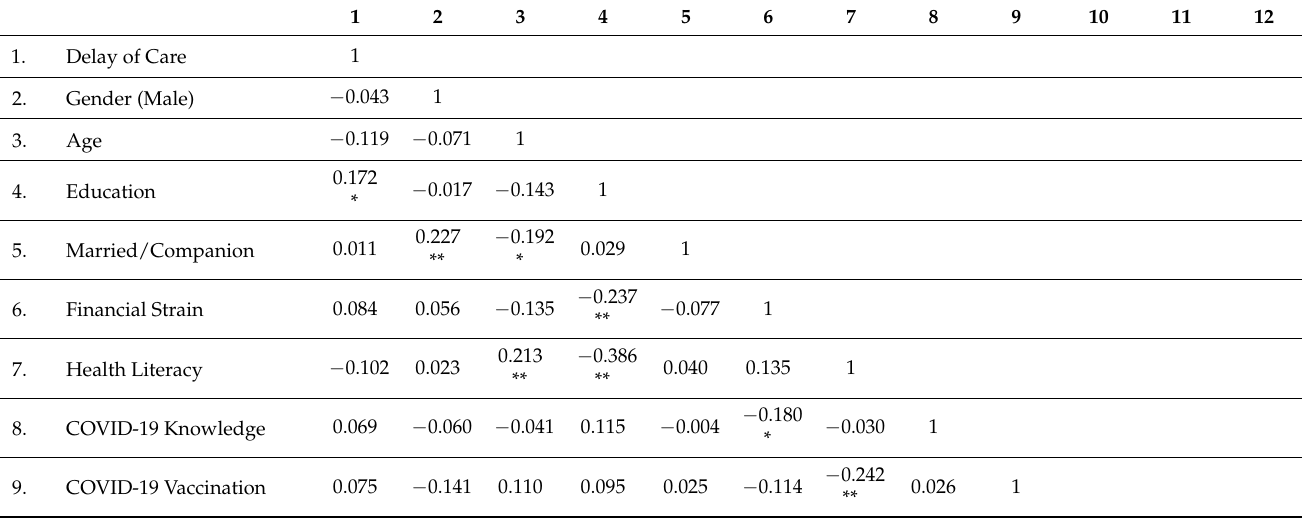
Table 2. Bivariate Correlations Between Delayed Care and Other Study